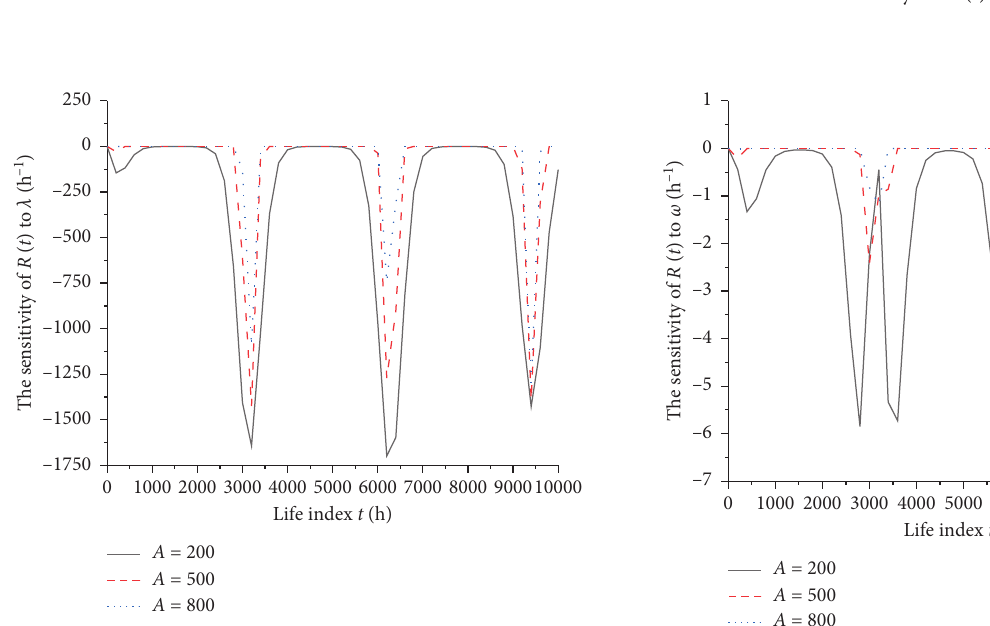
Figure 27: The sensitivity of h ( t ) to λ ( A � 200/500/800).